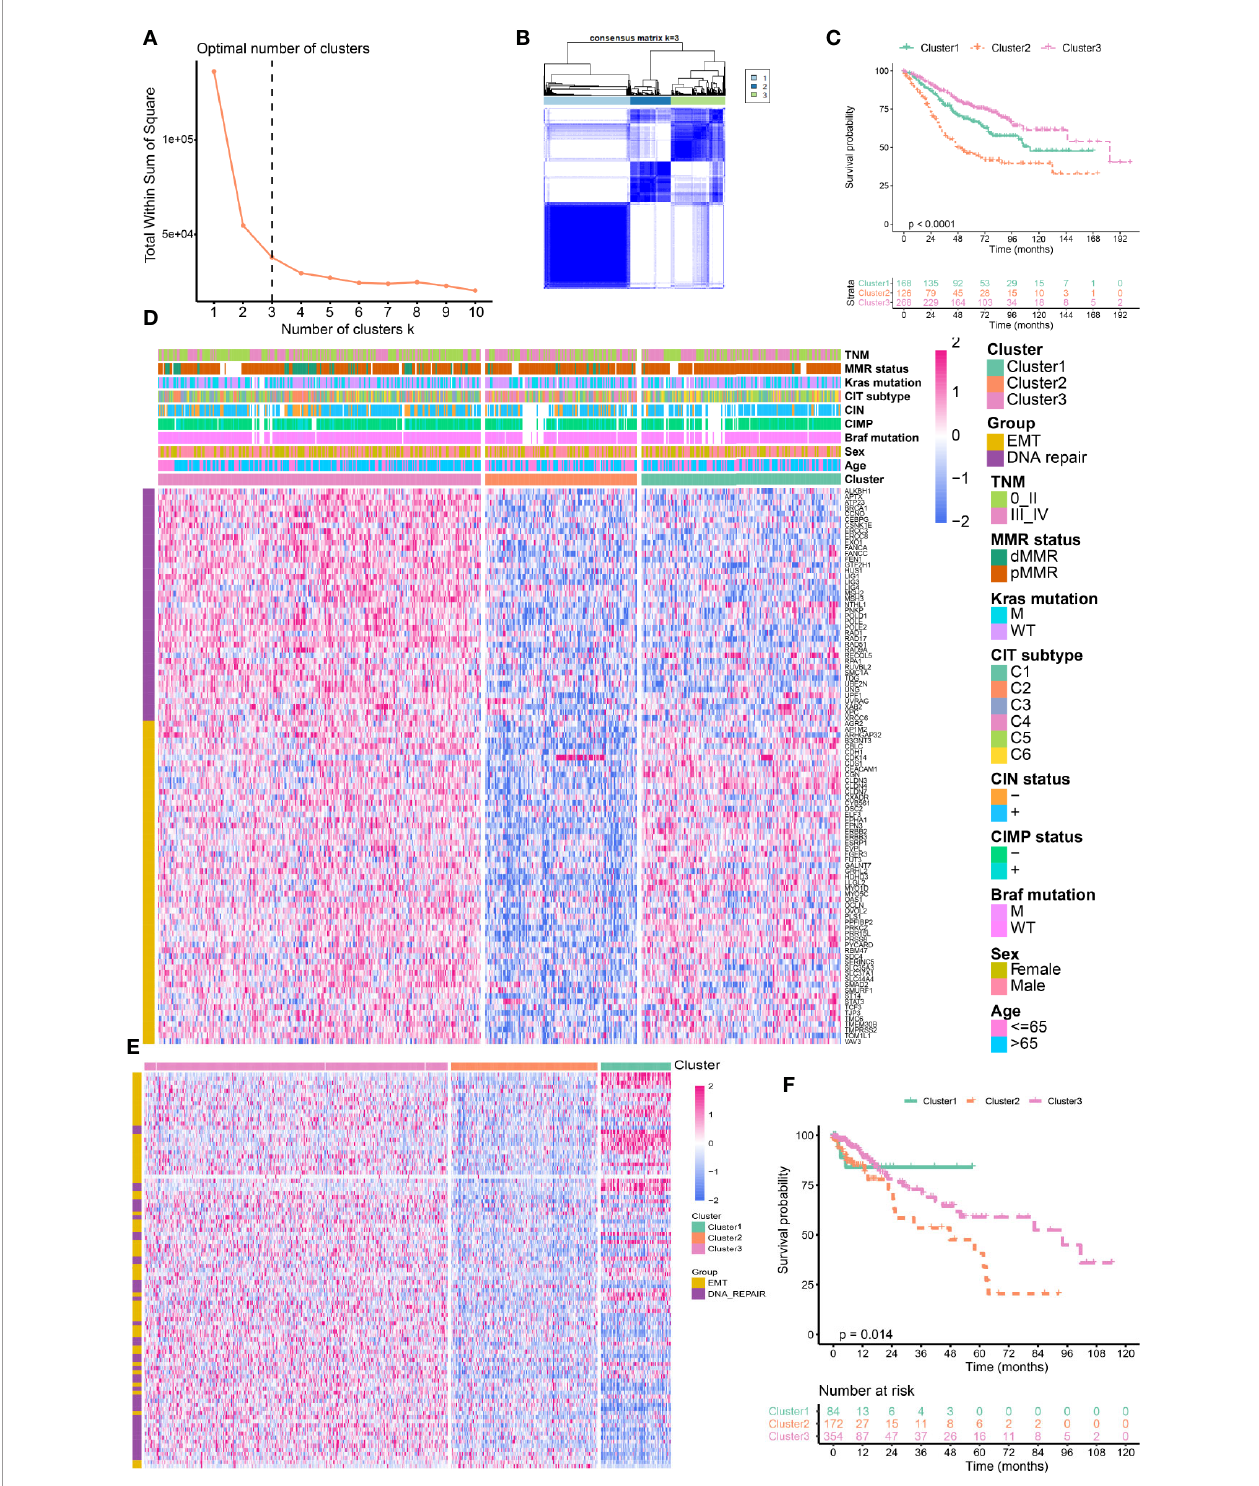
FIGURE 1 | Identi fi cation of distinct molecular clusters based on epithelial mesenchymal transformation (EMT) and DNA repair genes. (A) The optimal number of clusters determined by Elbow method. (B) Consensus matrix for k = 3. (C) Overall survival of colorectal cancer (CRC) patients in the three clusters (GSE39582). (D) Heatmaps show the expression of 98 EMT and DNA repair genes (GSE39582). (E) Heatmaps show the expression of 98 EMT and DNA repair genes (TCGA). (F) Overall survival of CRC patients in the three clusters